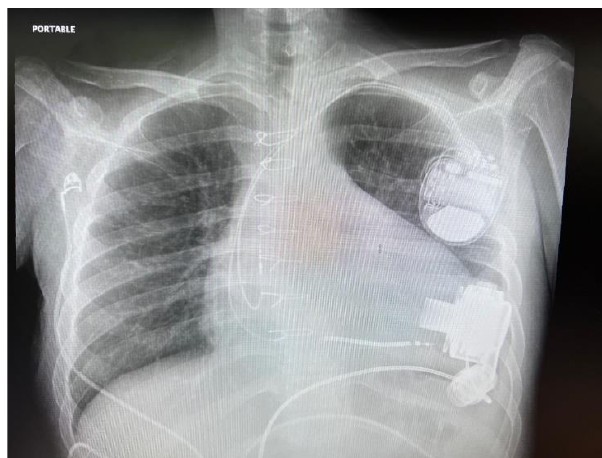
Figure 1. Chest X-ray post LVAD insertion with s/p ppm.